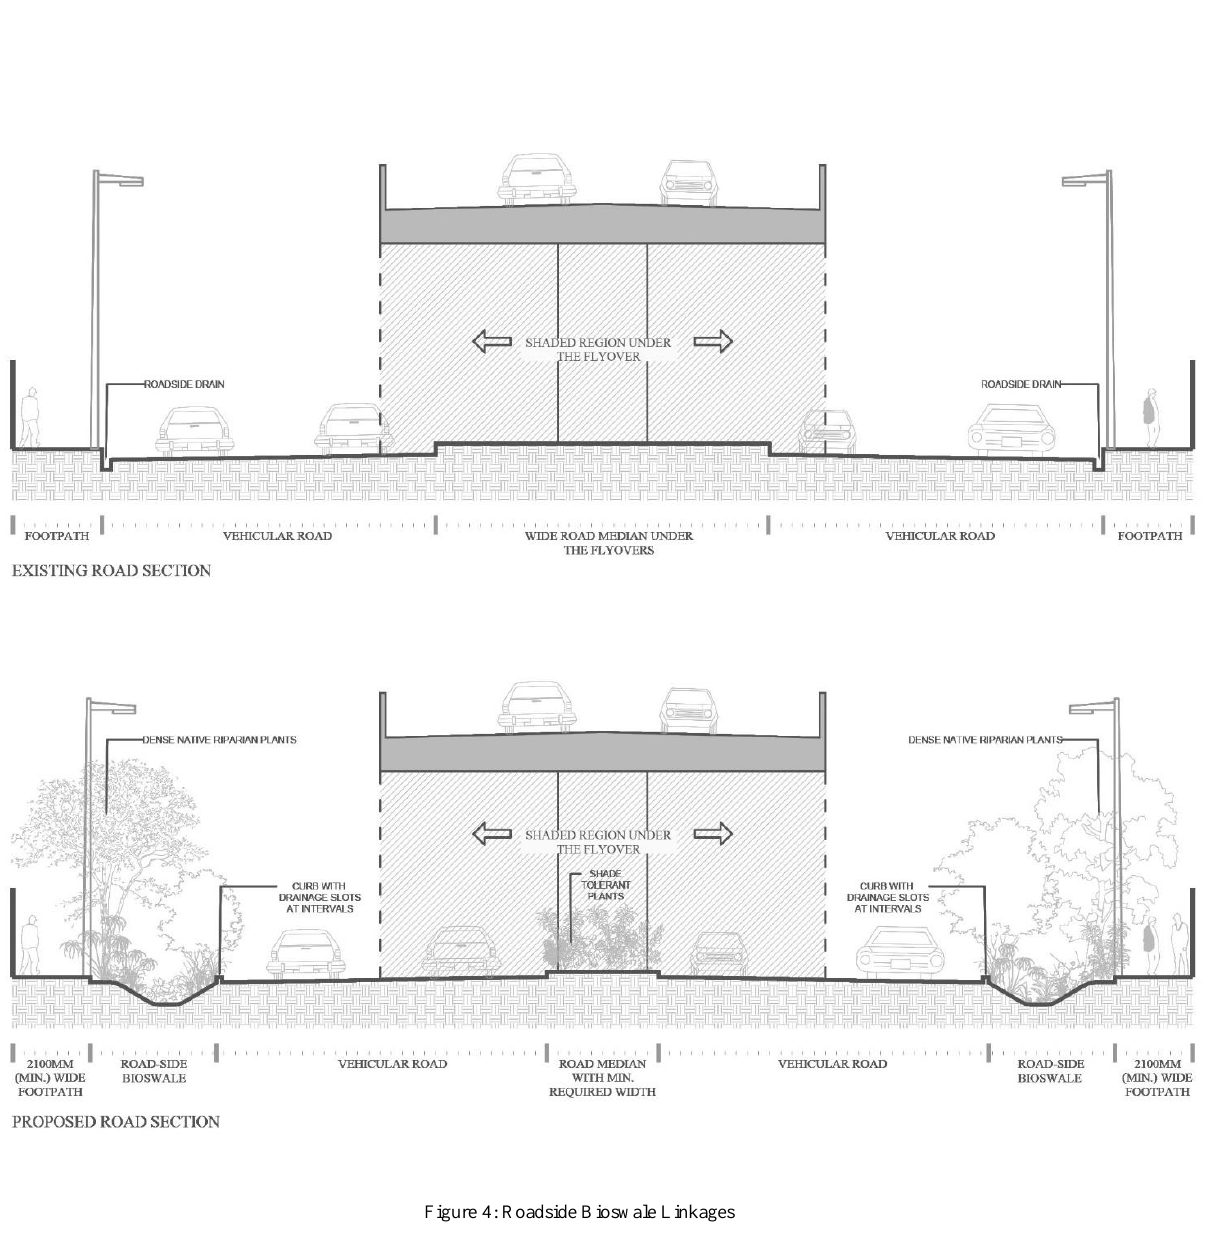
Figure 4: Roadside Bioswale